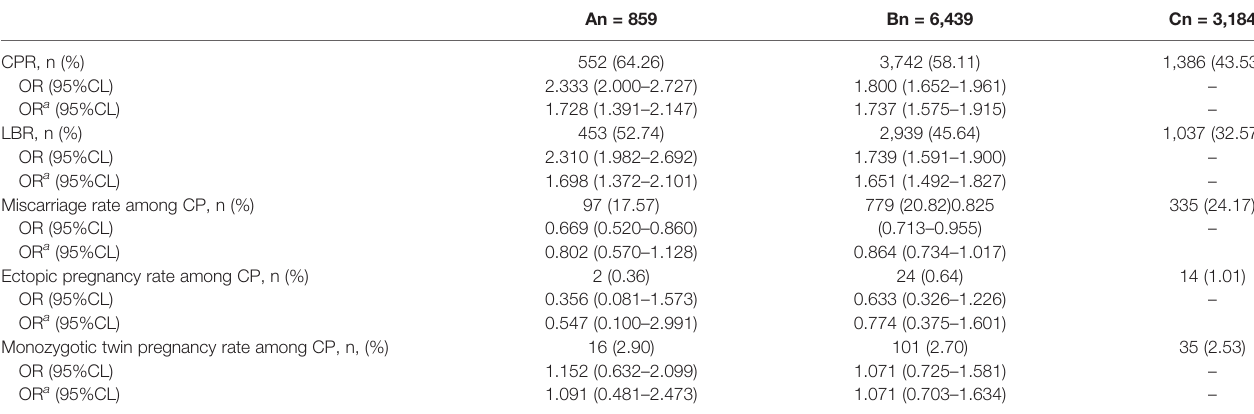
TABLE 4 | Pregnancy outcomes according to the TE